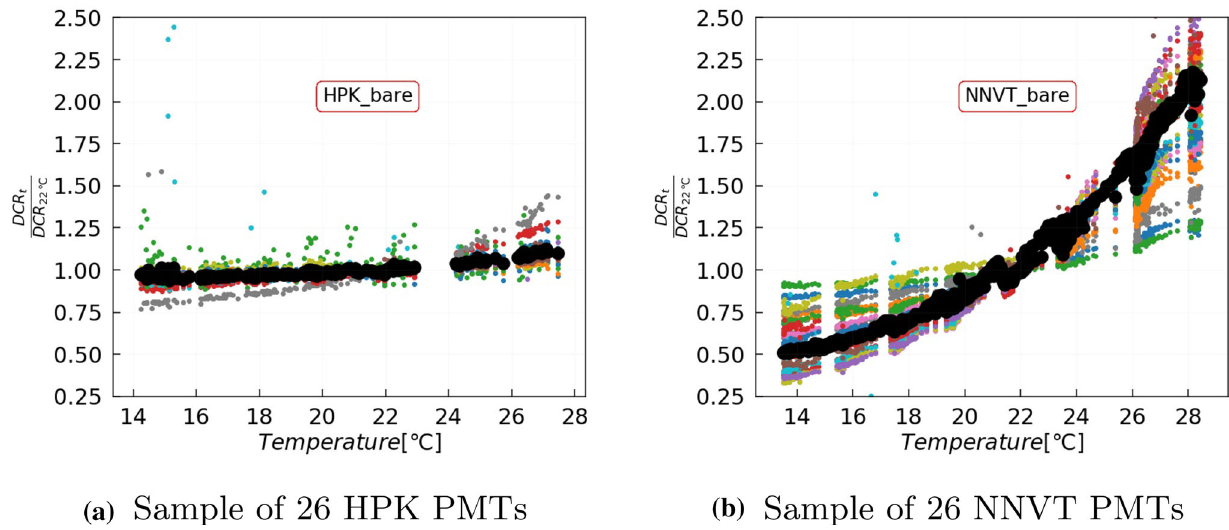
Fig. 23 Measured DCR versus temperature in a specific temperature survey. The black dots represent the averaged trend of all measured PMTs under the same temperature. The discrete points far from the trend are generated by noise during the